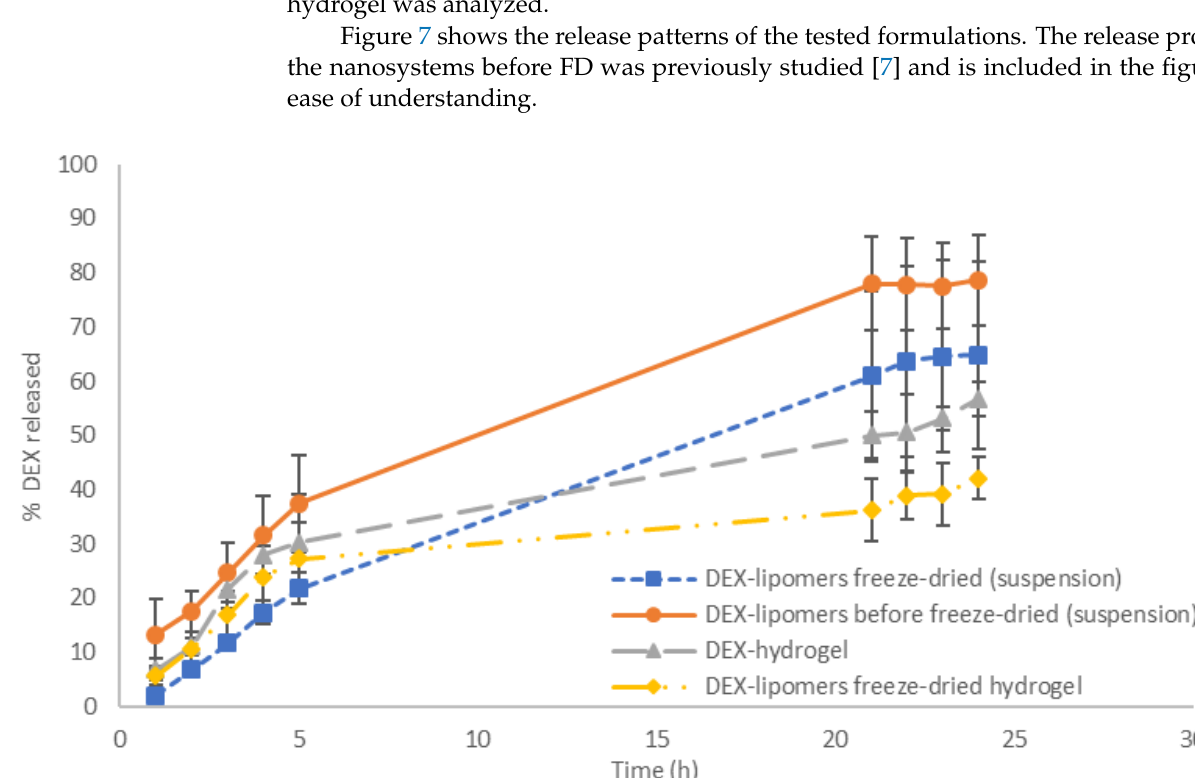
Figure 7. DEX release percentages of the tested formulations ( n = 6). Results shown mean and standard deviation values.